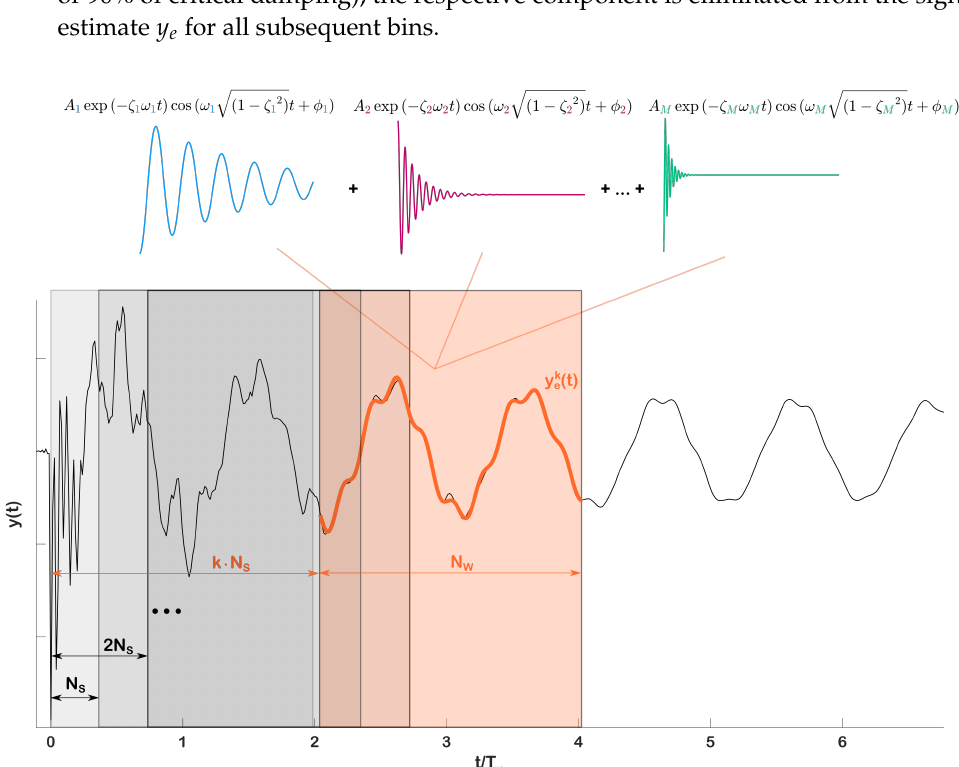
Figure 2. Binning of the time data and NLS fitting